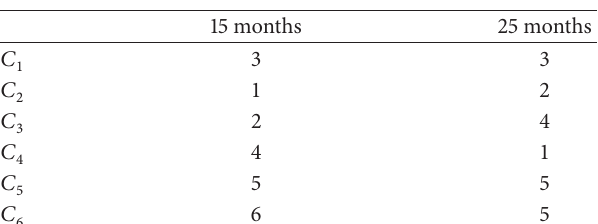
Table 7: Criteria ranking for green supply chain considering